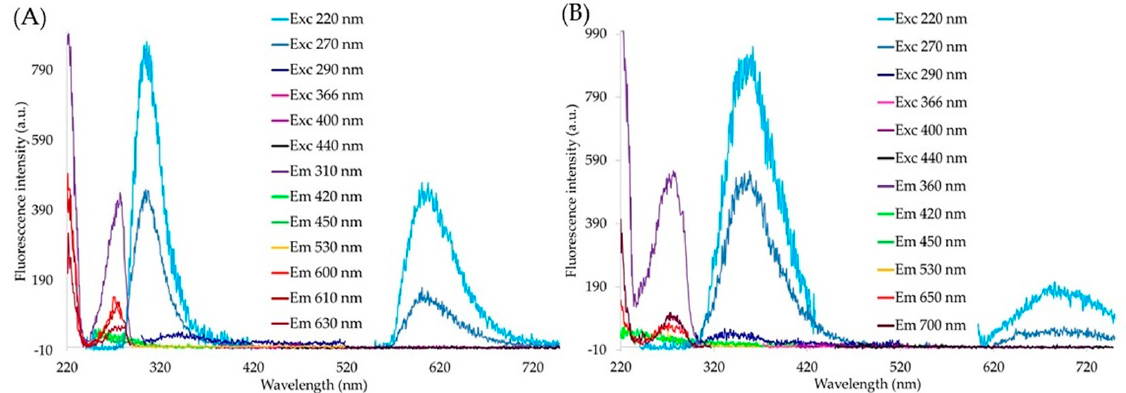
Figure 2 . Emission and excitation spectra recorded from L-tyrosine ( A ) and L-tryptophan ( B ) freshly prepared solutions. Excitation and emission conditions are indicated by colors in the inlet legend.